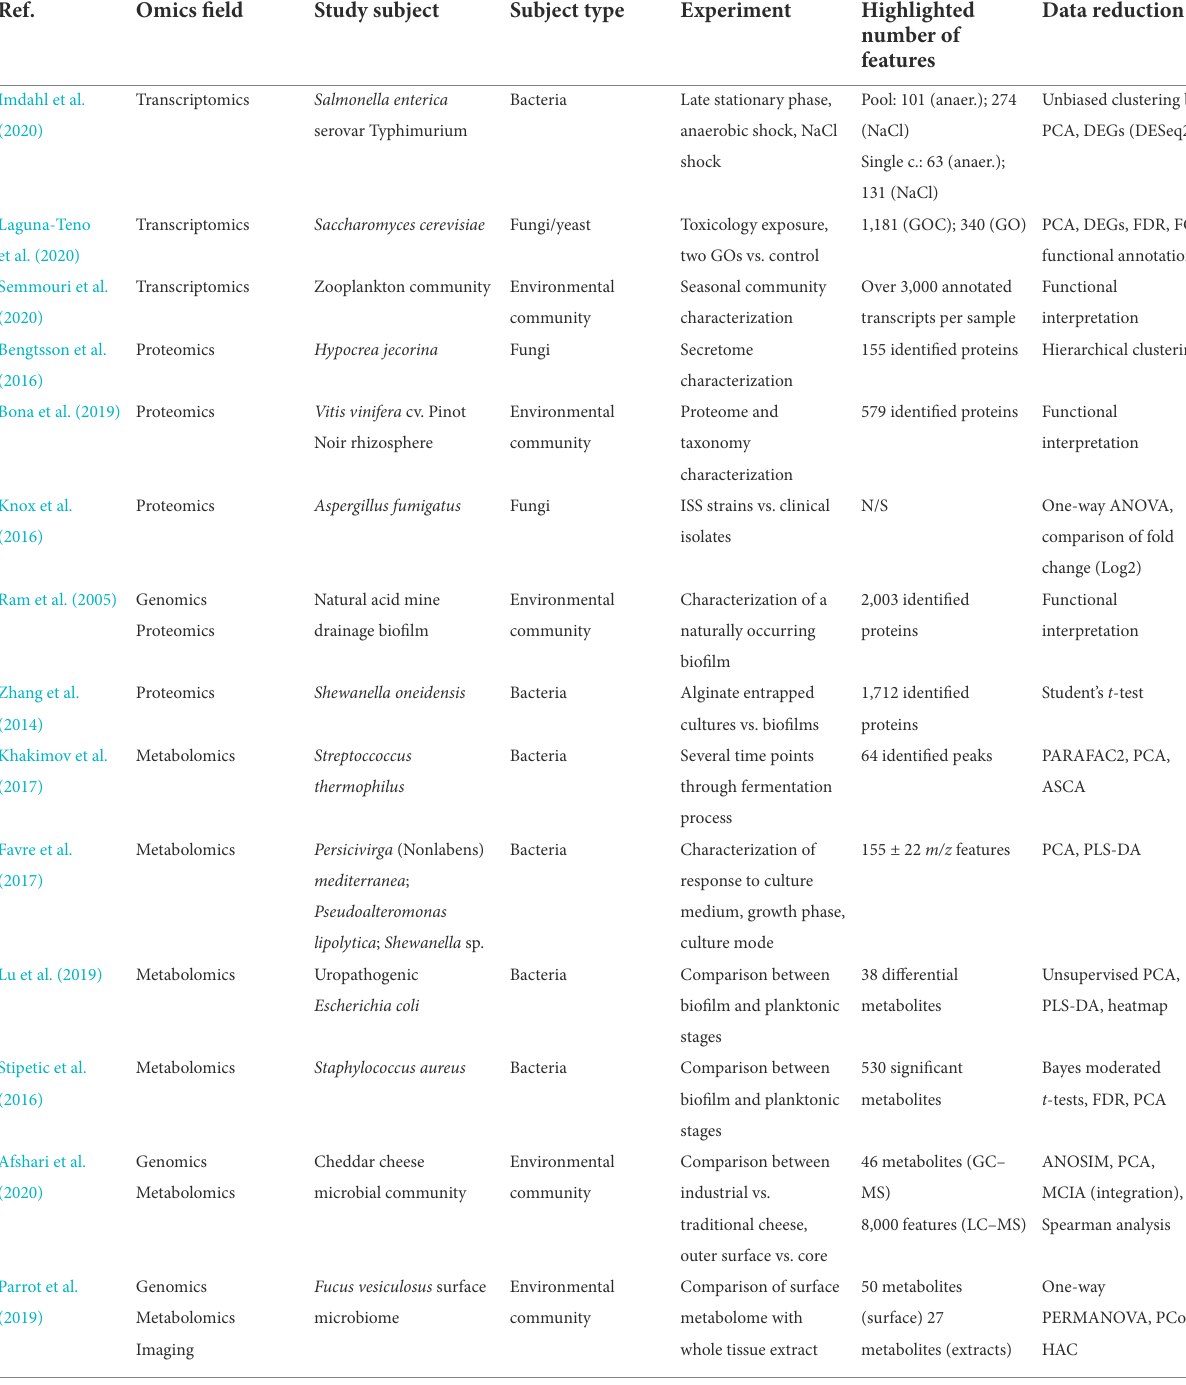
TABLE 2 Summary of studies involving use of one or more omics methodologies and the statistical data reduction commonly applied.